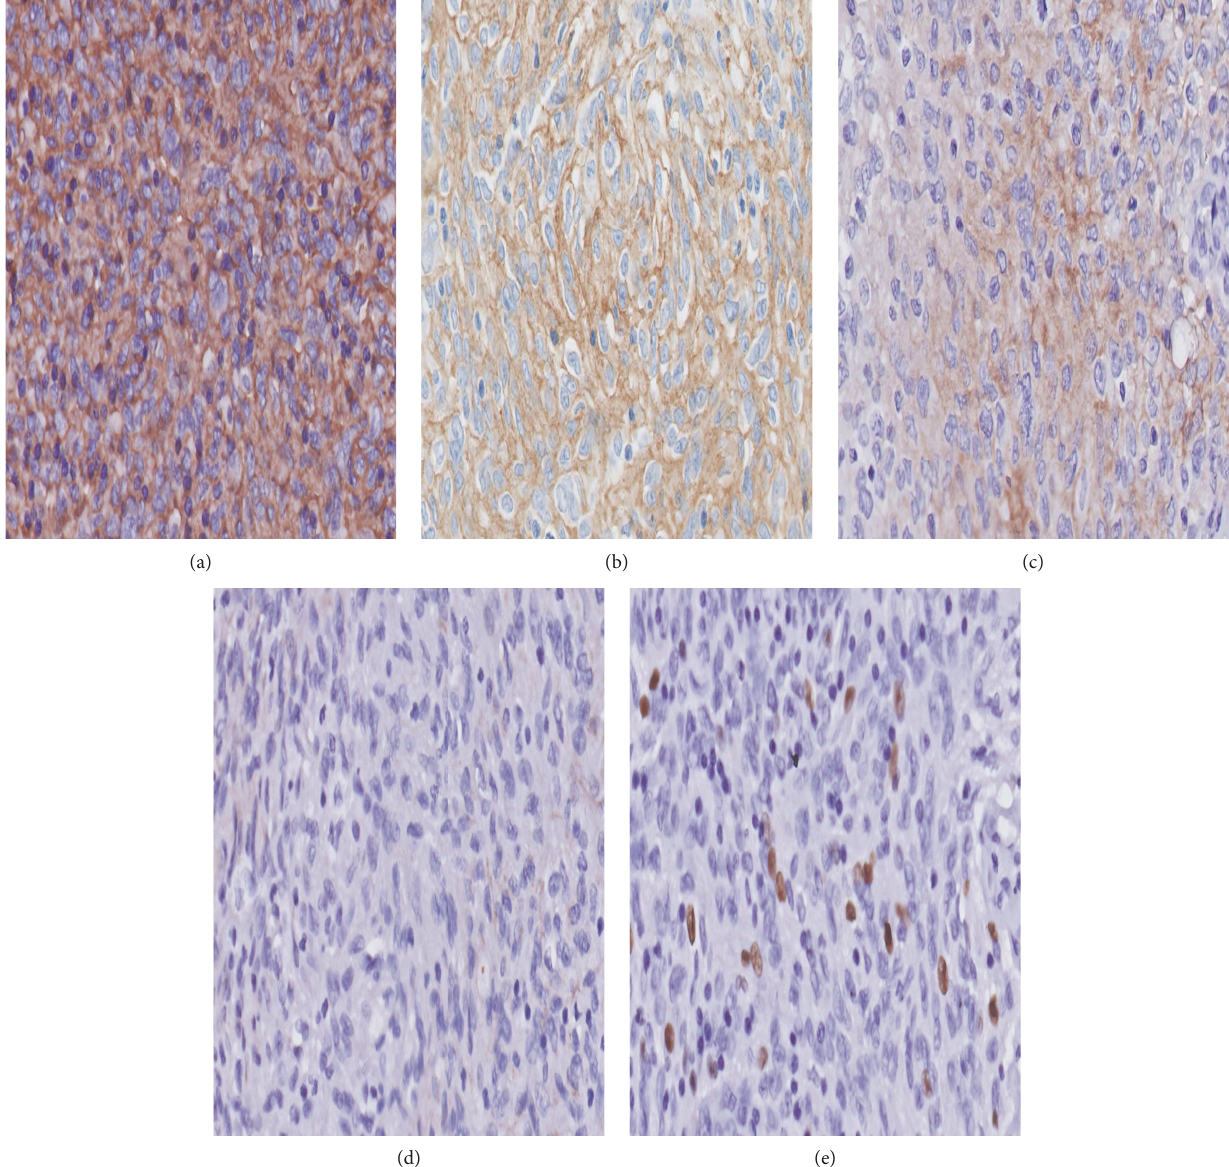
Figure 6: (a) Tumor cells show strong membranous staining for CD23 (magni fi cation, 400x). (b) Tumor cells show positive staining for CD35 (magni fi cation, 400x). (c) Tumor cells show weak membranous staining for CD21 (magni fi cation, 400x). (d) Tumor cells show negative staining for panCK (magni fi cation, 400x). (e) Tumor has a low mitotic activity of 4 – 5% (magni fi cation,